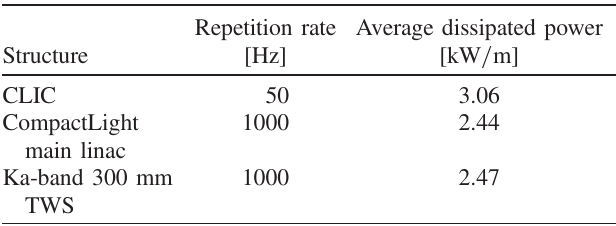
TABLE IV. Comparison of average dissipated power.